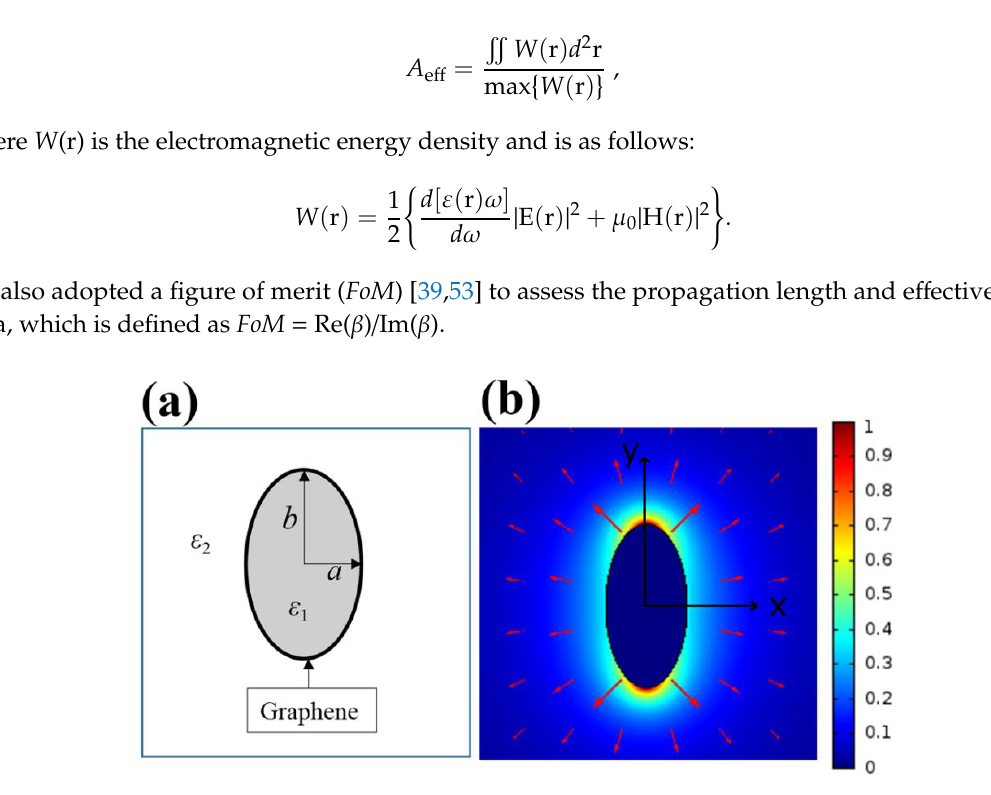
Table 1. The mode properties versus b / a , and a = 0.5 μm, u c = 0.5 eV, ε 1 = 2.25, and ε 2 = 1.